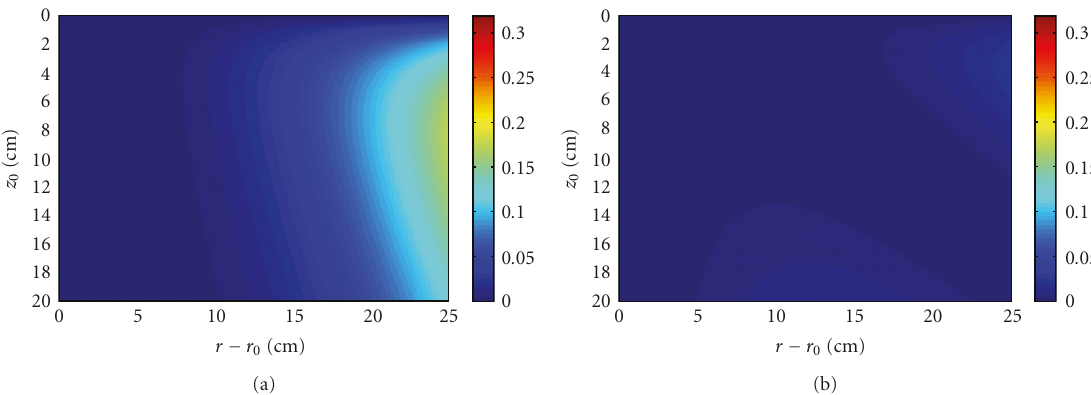
Figure 1: Travel time error [ns] for the rms approximation (a) and for the LLNL approximation (b) as a function of z 0 (target depth) and r − r 0 (lateral distance of the antenna from the vertical above the target). The system is monostatic. The antenna-medium distance is 10cm, and the radar wave velocity into the medium is 12cm/ns.